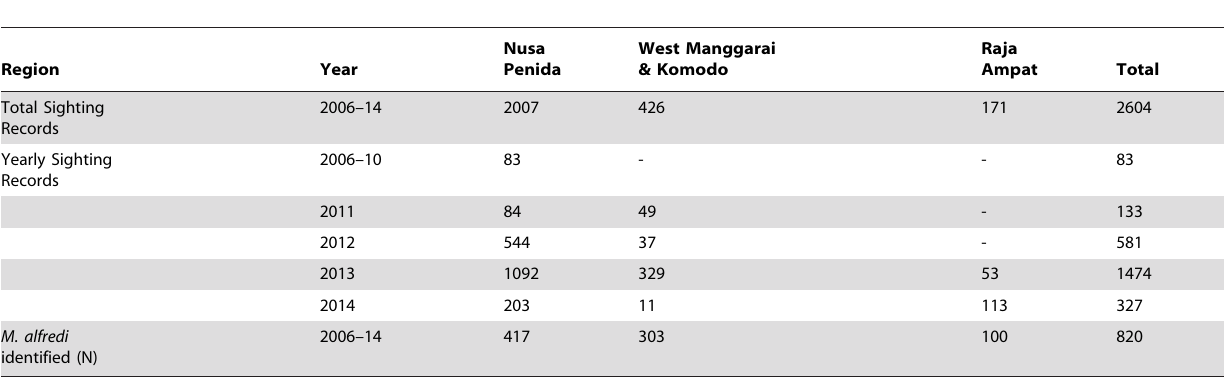
Table 1. The survey effort in Nusa Penida, West Manggarai & Komodo, and Raja Ampat regions including sighting records and number of individuals identified.